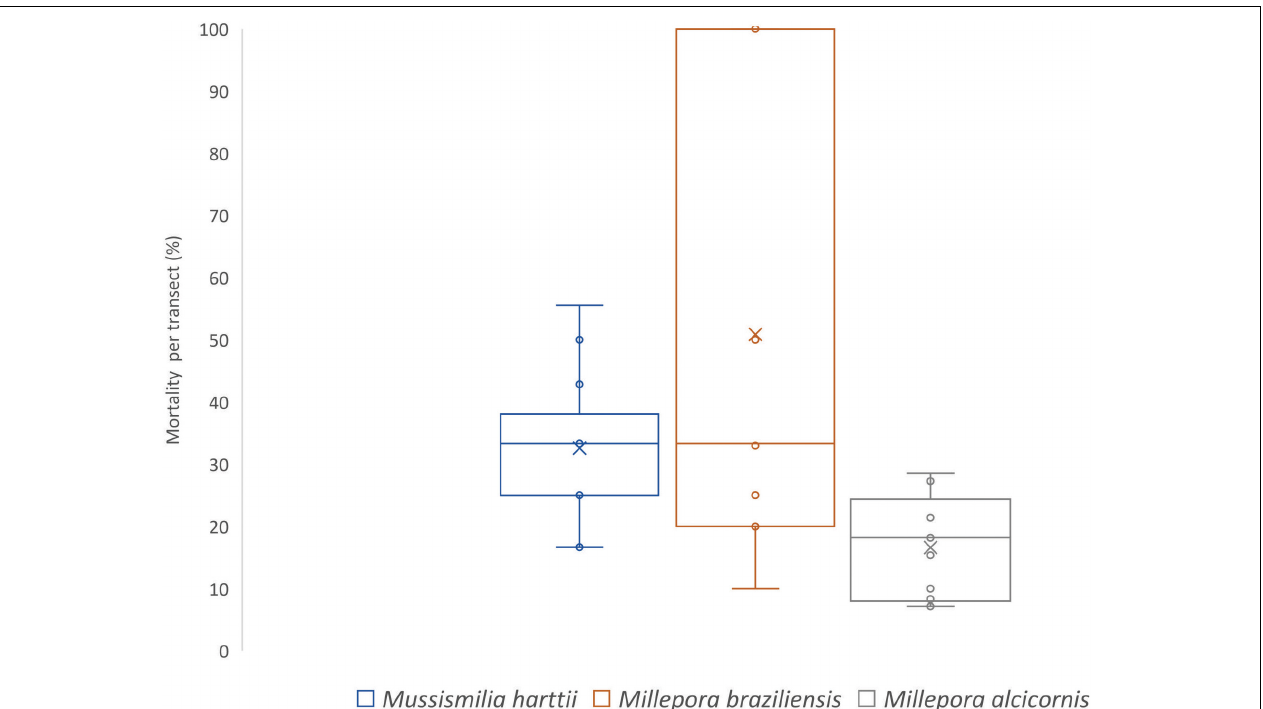
FIGURE 6 | Coral mortality per transect at marine protected area (MPA) Costa dos Corais during post-bleaching period for Mussismilia harttii , Millepora braziliensis , and Millepora alcicornis ,